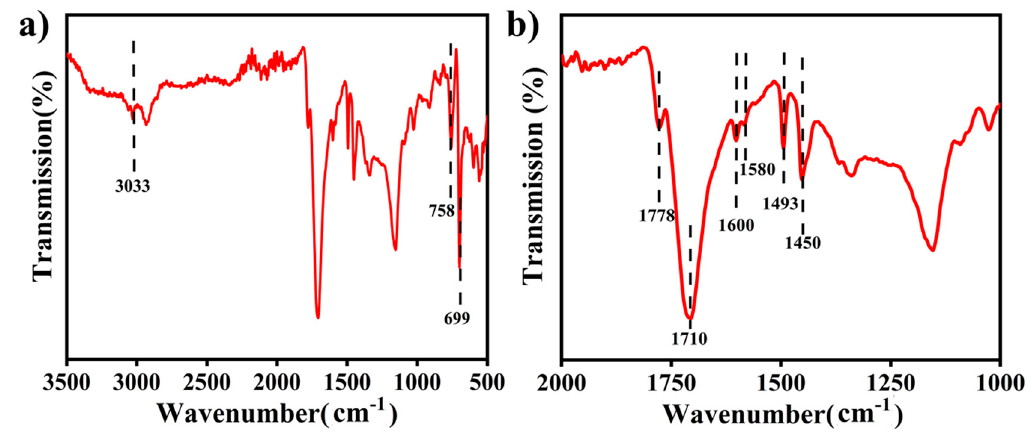
Figure 4. FT-IR diagram of polymer shell without the γ -Al 2 O 3 pellet in transmission mode. ( a ) 3500-500 cm − 1 ; ( b ) 2000-1000 cm − 1 .